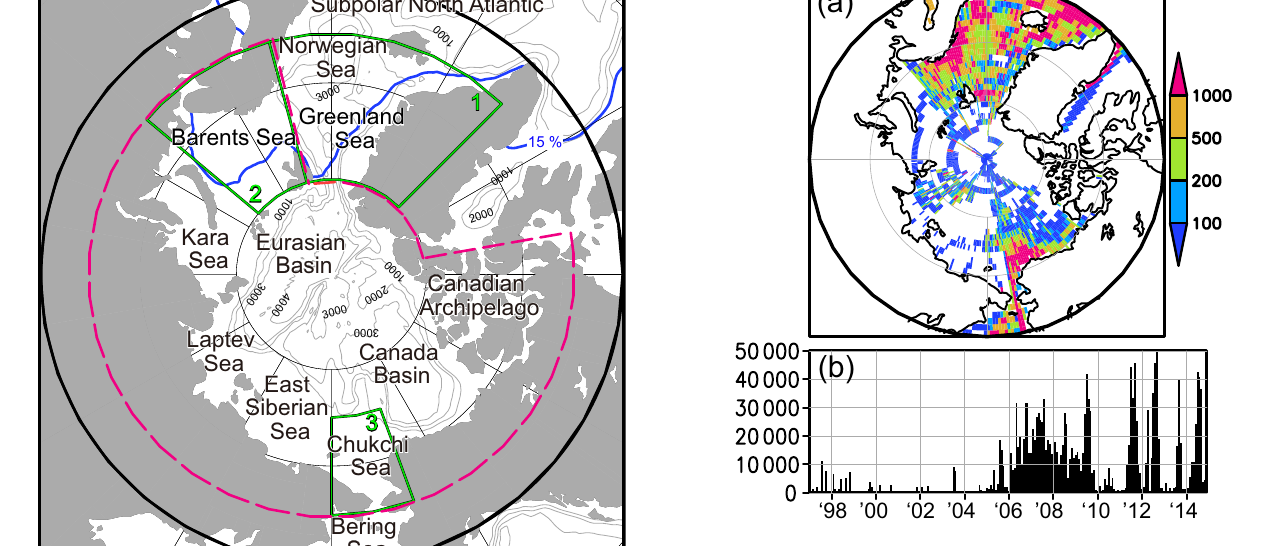
Figure 2. (a) The number of ocean surface CO 2 data in the grid boxes (1 ◦ × 1 ◦ ) used in this study. Data are from SOCATv4, LDEOv2014, and GLODAPv2 and those collected by R/V Mirai of JAMSTEC between 1997 and 2014. (b) Monthly number of CO 2 data in the analysis area (north of 60 ◦ N) from 1997 to